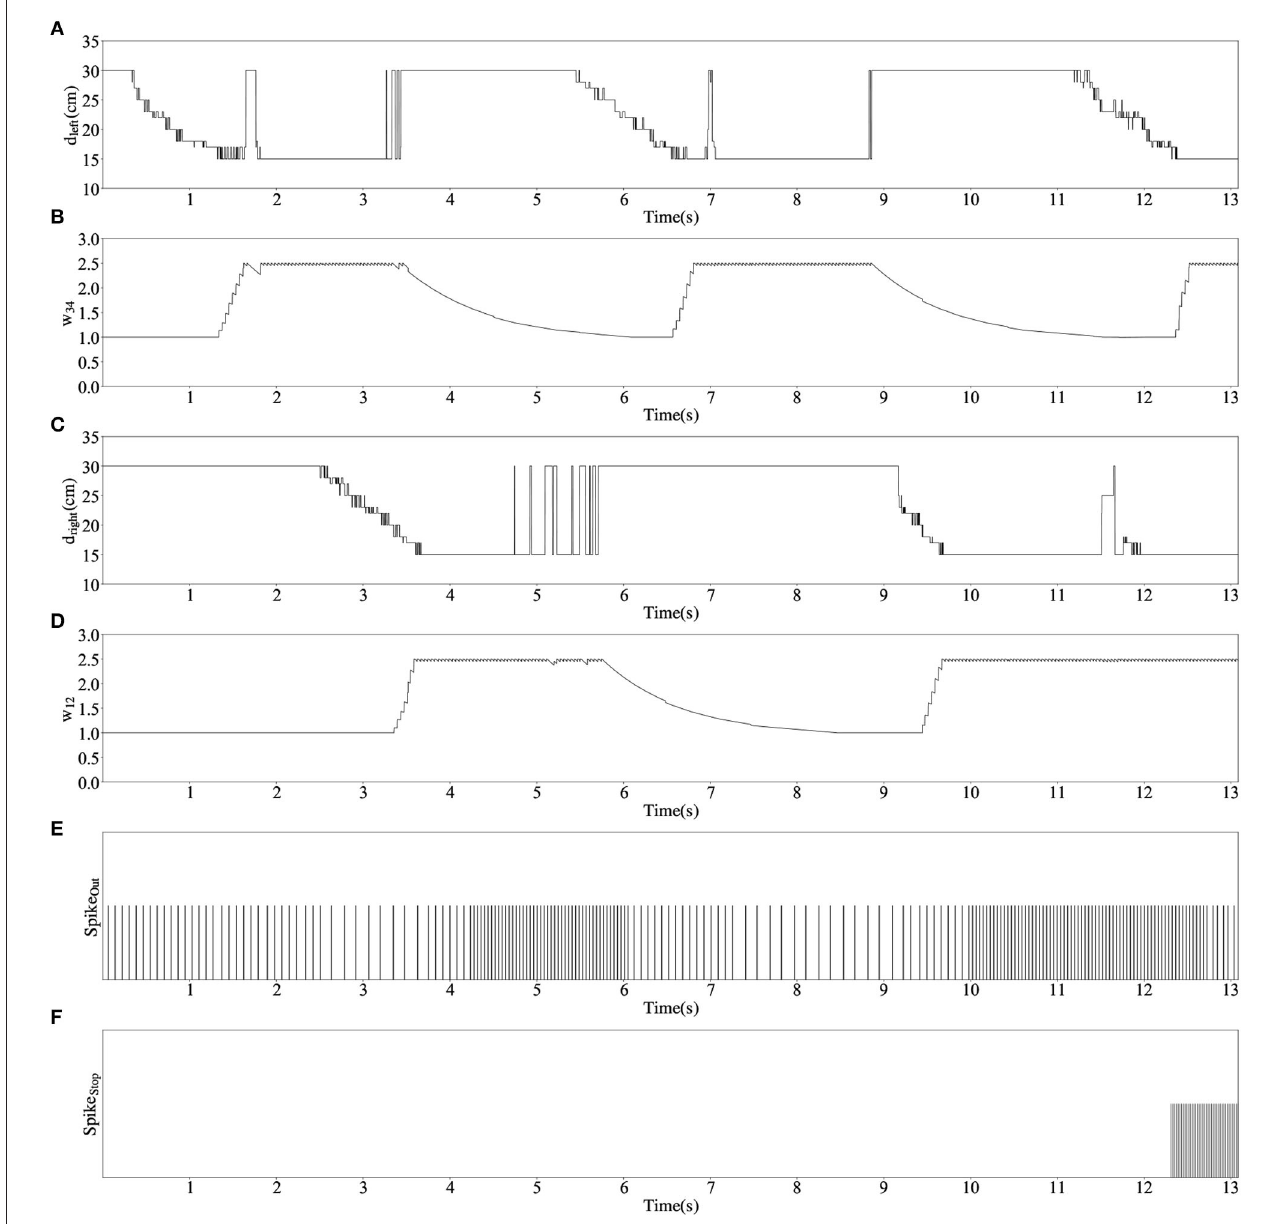
FIGURE 10 | Parameters’ changes in the obstacle avoidance test, where (A) is the distance data measured by left ultrasonic sensor, (B) is the synaptic weight w 34 , (C) is the distance data measured by the right ultrasonic sensor, (D) is the synaptic weight w 12 , (E) is the spike fired by neuron out, and (F) is the spike fired by neuron